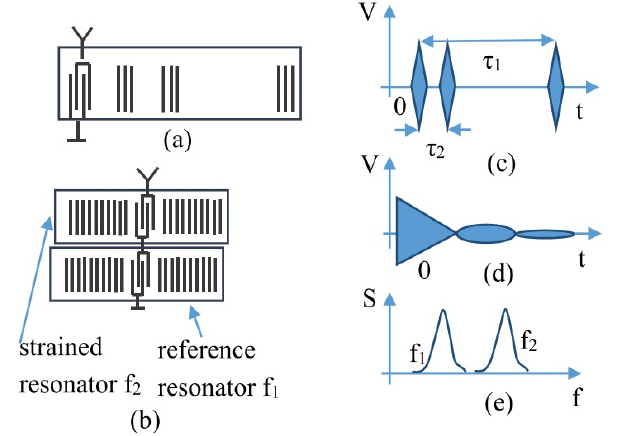
Figure 7. Reflective delay line sensor (a) , resonant sensor (b) , im- pulse responses of the delay line (c) , the resonant (d) sensors, and the spectrum of the resonator response (e) (Kalinin